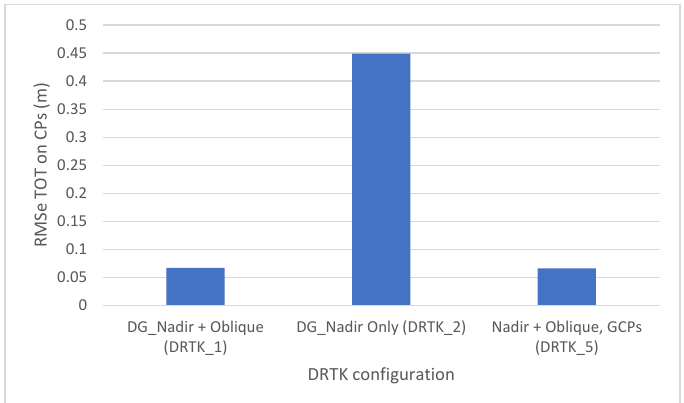
Figure 7. RMSE TOT of CPs for different DRTK configurations (DRTK_1, DRTK_2, and DRTK_5).